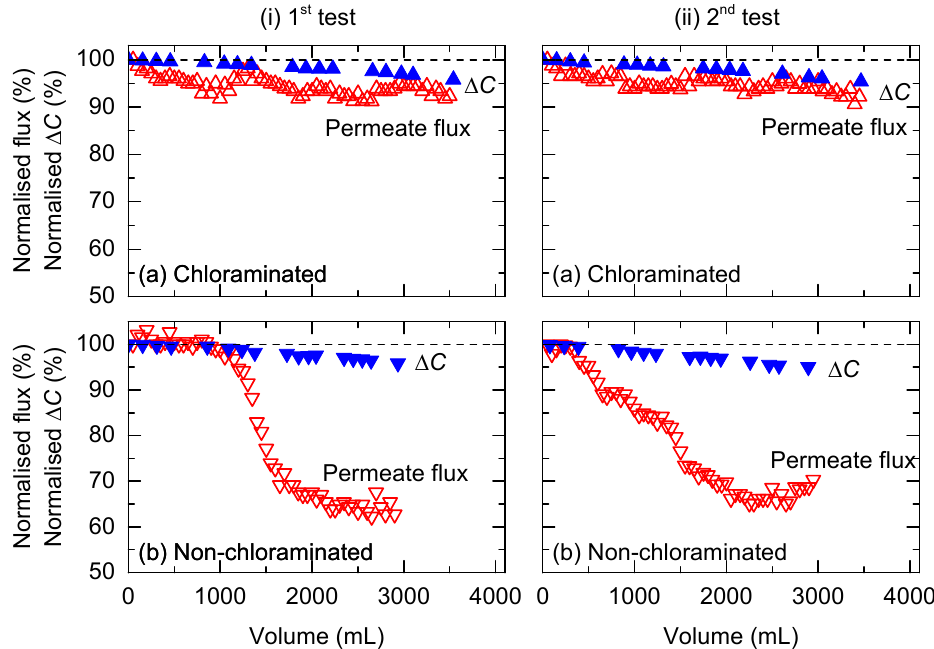
Figure 6. Reduction in normalised flux and conductivity difference between the FS and DS ( ∆ C ) during the (i) first and (ii) second pre-concentration tests using primary wastewater effluent: ( a ) chloraminated and ( b ) non-chloraminated FO systems.